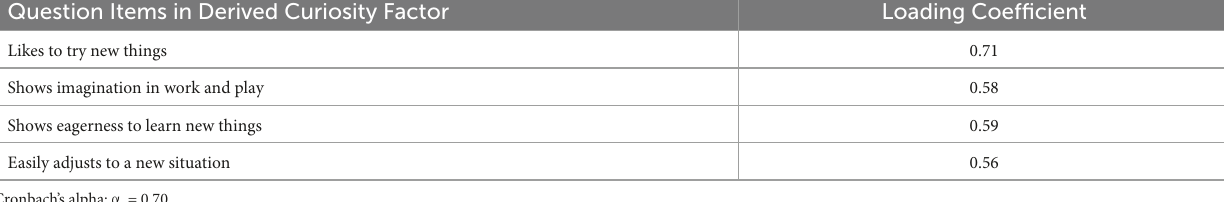
TABLE A1 Derived curiosity factor from the